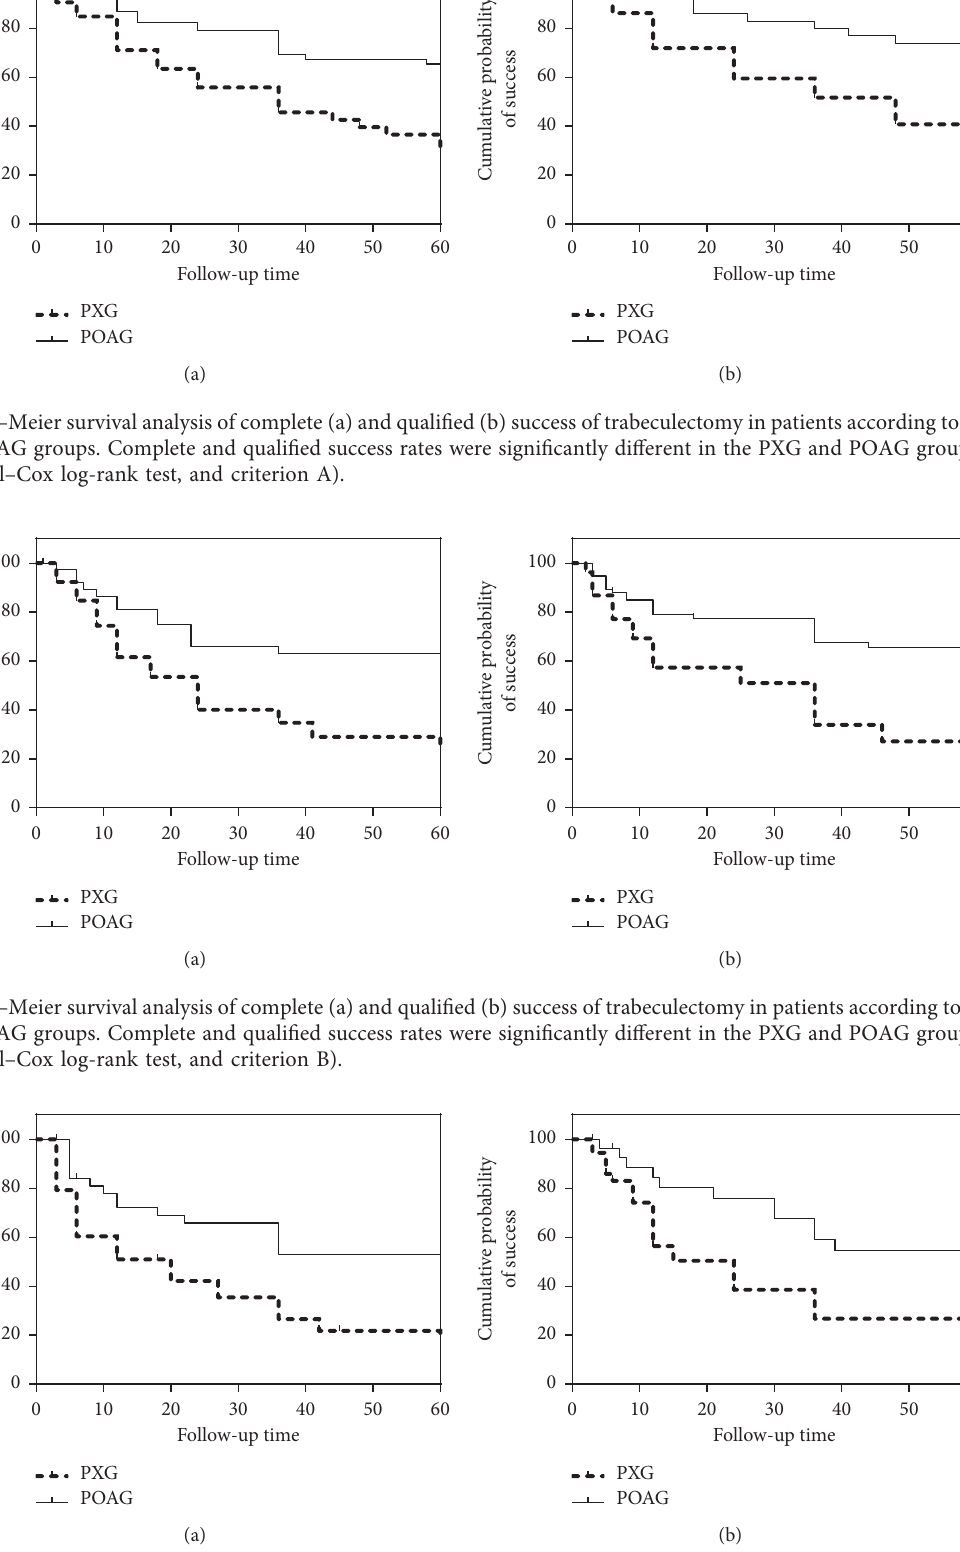
Figure 3: Kaplan–Meier survival analysis of complete (a) and qualified (b) success of trabeculectomy in patients according to criterion C in the PXG and POAG groups. Complete and qualified success rates were significantly different in the PXG and POAG groups ( P � 0 . 001, P � 0 . 009, Mantel–Cox log-rank test, and criterion